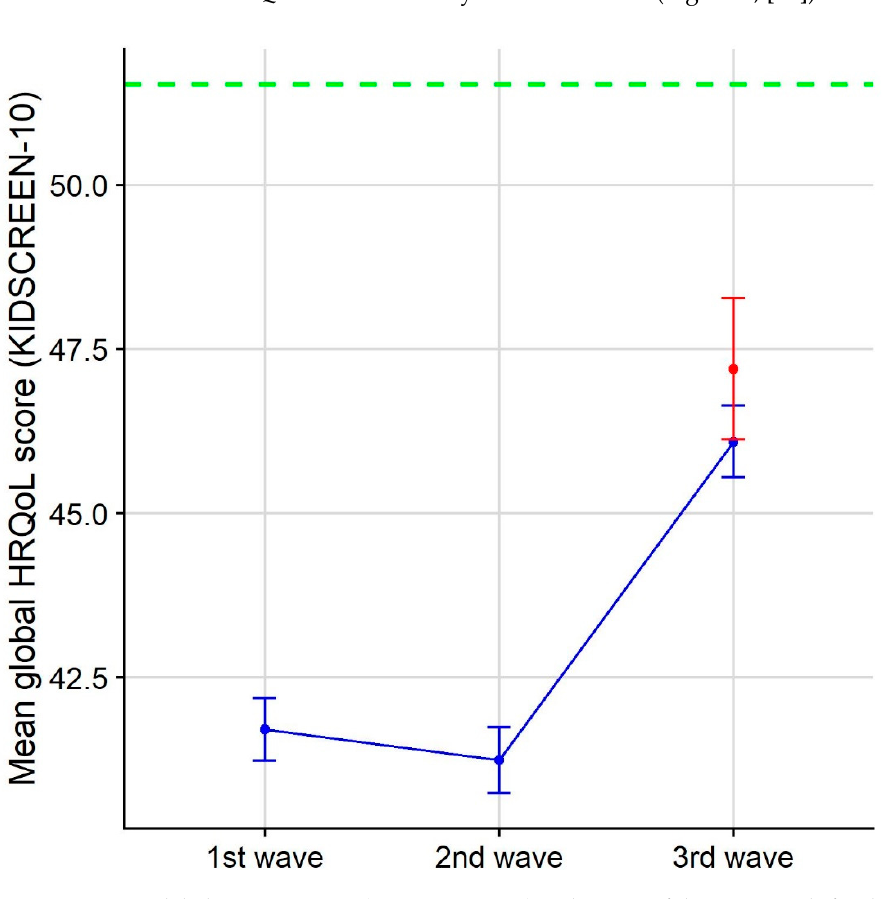
Figure 3. Mean global HRQoL scores (KIDSCREEN-10) and 95% confidence intervals for the Waldorf third-wave sample (in red) and for the COPSY first-, second-, and third-wave samples (in blue) (data provided by U. Ravens-Sieberer). The green-dashed line shows the German national norm data for the KIDSCREEN-10 HRQoL score of 8–18-year-old children from the proxy report (Table A7_B-32, [30]). Table 4. Mean values ± standard deviations of the global HRQoL score (KIDSCREEN-10 Index, parent-proxy report) for Waldorf and COPSY sample.